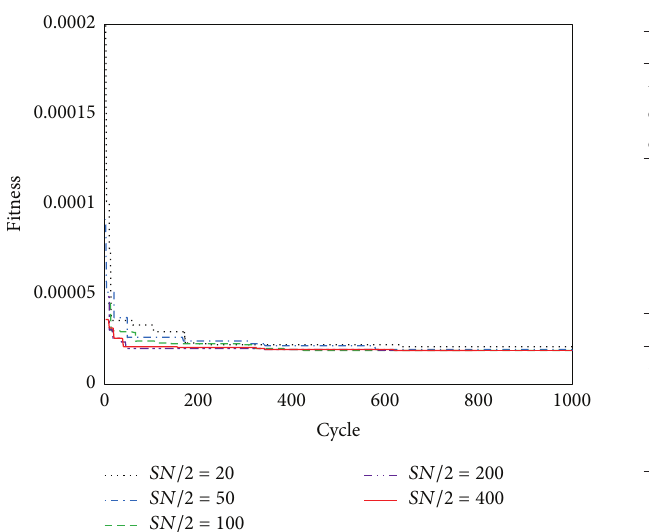
Figure 8: The performance of ABC using different searching ranges.